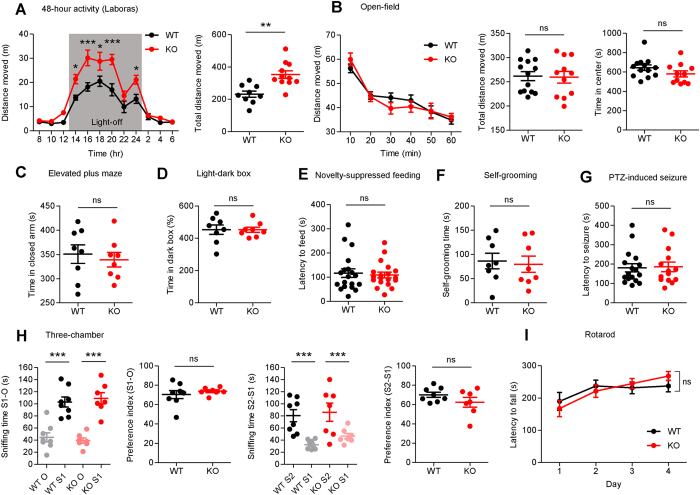
Dorfin−/− mice display hyperactivity in a familiar, but not in a novel, environment, and show normal levels of anxiety-like behavior, self-grooming, seizure propensity, social interaction, and motor coordination.(A) Dorfin−/− mice display enhanced locomotor activity in a familiar environment, as measured by 48-hour continuous monitoring of mouse movements in a familiar environment averaged in a 24-hour cycle (Laboras, n = 9 mice for WT and 11 for KO, two-way ANOVA, Bonferroni post-hoc, ***p < 0.001, **p < 0.01, *p < 0.05, Student’s t-test for total moved distance). (B) Dorfin−/− mice show normal locomotor activity in the open field test (novel environment). Note that the time spent in the center region is also normal. (s.e.m., n = 13 mice for WT and 11 for KO, ns, not significant, two-way ANOVA, Bonferroni post-hoc, Student’s t-test). (C–E) Dorfin−/− mice display normal levels of anxiety-like behavior in elevated plus maze (C), light-dark box (D), and novelty-suppressed feeding tests (E) (s.e.m, n = 8 mice for WT and KO in elevated plus-maze and light-dark box tests and 19 for WT and KO mice in the novelty-suppressed feeding test, ns, not significant, Student’s t-test). (F–I) Dorfin−/− mice show normal levels of self-grooming (F), PTZ-induced seizure (G), three-chamber social interaction (H), and rotarod motor coordination (I) (s.e.m., n = 8 mice for WT and KO [self-grooming], 17 for WT and 14 for KO [seizure], 8 for WT and KO [three-chamber], and 12 for WT and KO [rotarod], ns, not significant, Student’s t-test).